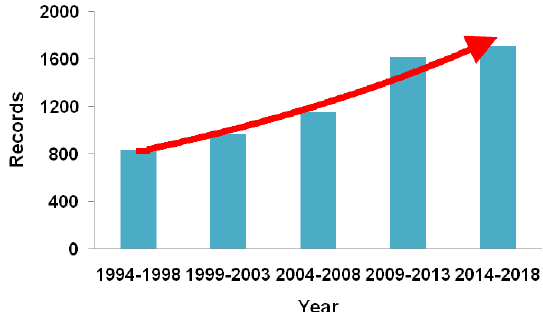
Fig. 2. Records of skin cancer research using FLIM from 1997 to 2018.